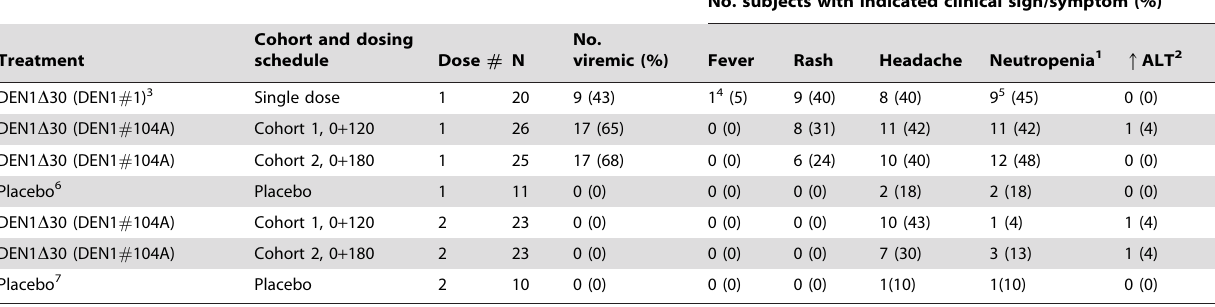
No. subjects with indicated clinical sign/symptom (%)